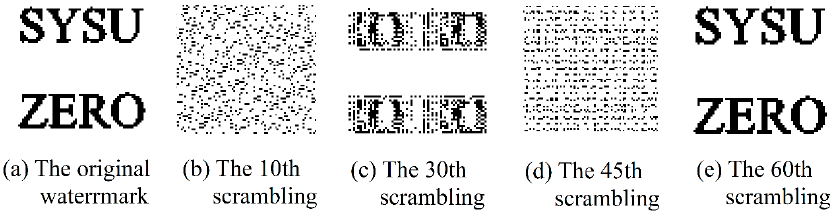
Figure 2. Arnold scrambling of the watermark image.